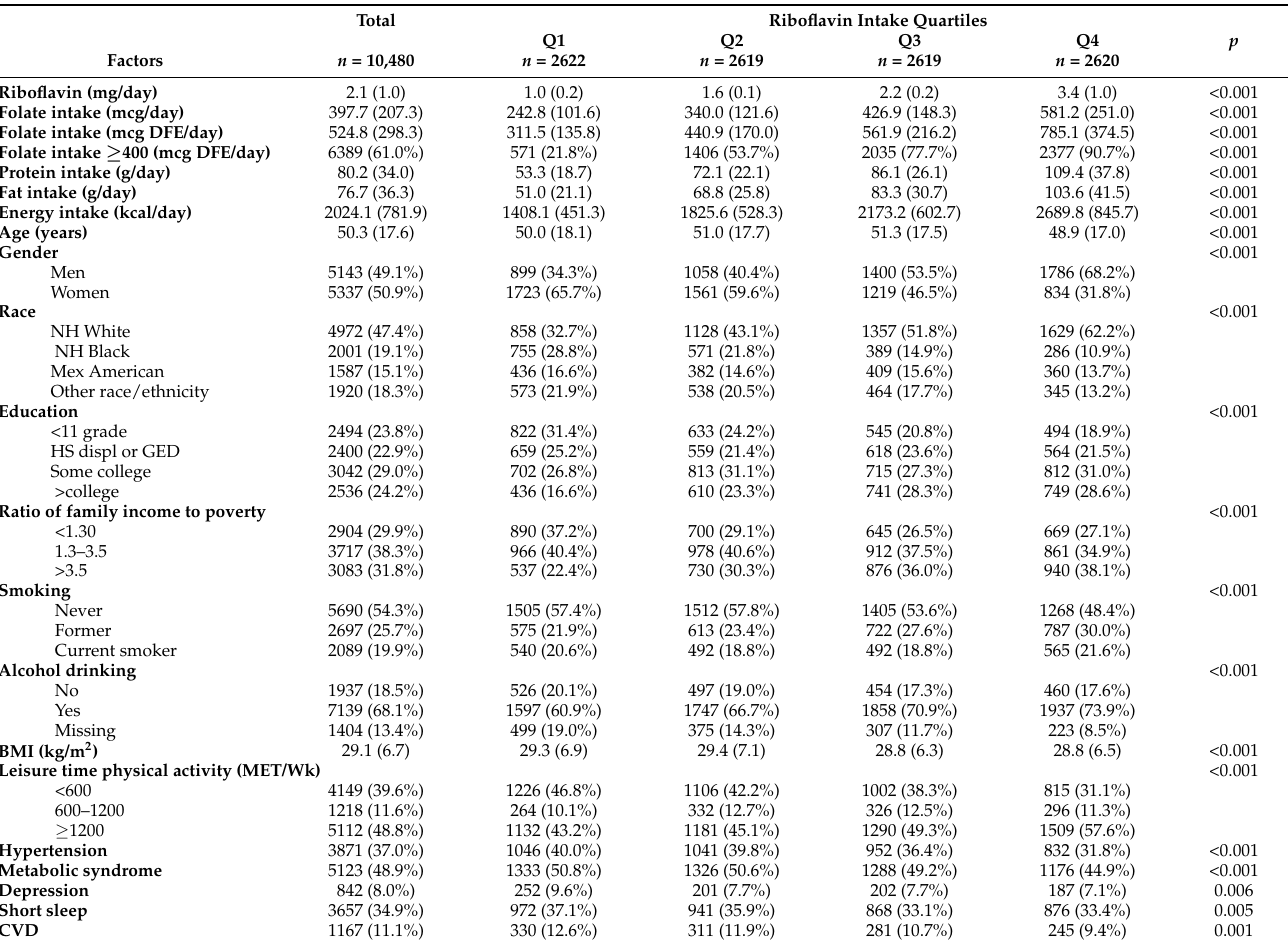
Table 1. Sample characteristics by quartiles of riboflavin and folate acid intake among adults attending NHANES 2005–2016 ( n =